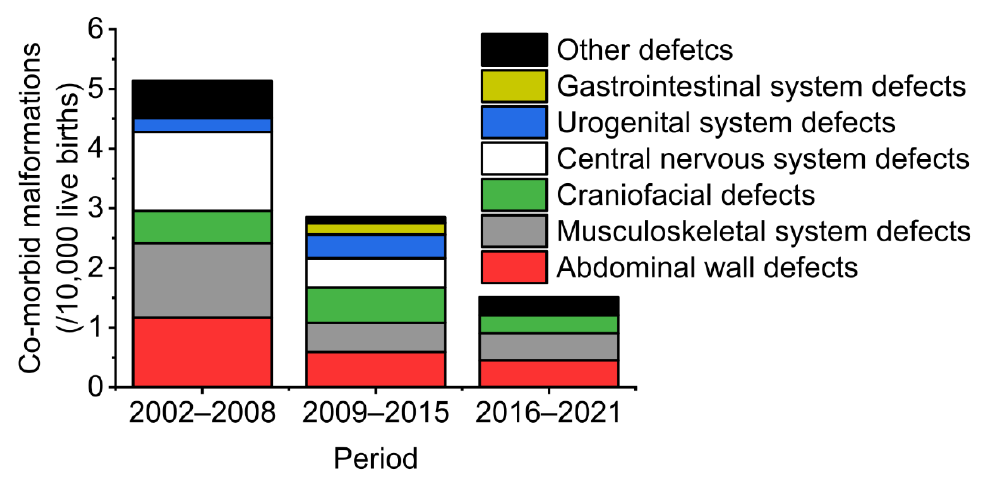
Figure 4. Prevalence of defects co-occurring with NTDs by period in five counties in Shanxi province of northern China, 2002–2021. 2002–2008 is the period before population-level folic acid supplemen- tation; 2009–2015 is the period after population-level folic acid supplementation; 2016–2021 is the period of population-level folic acid supplementation and the universal two-child policy; after 31 May 2021 is the period of population-level folic acid supplementation and the universal three-child policy.